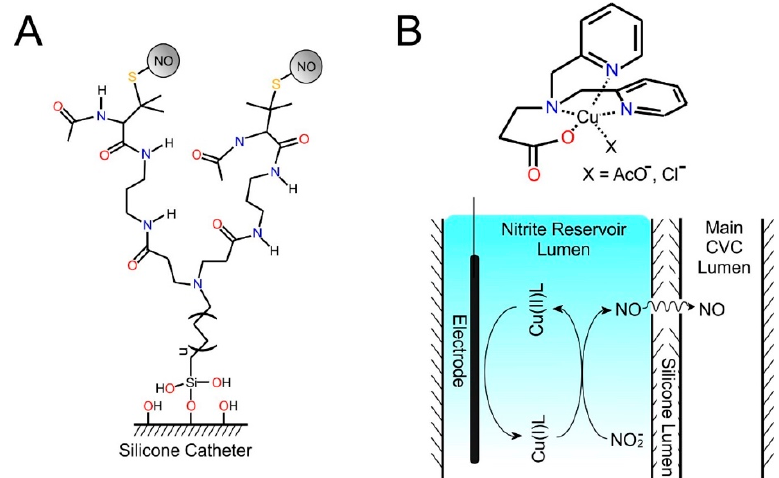
Figure 6. ( A ) Hyperbranched methacrylate-penicillamine based nitric oxide (NO) donors. ( B ) Dual lumen electrocatalytic release of nitric oxide using copper complexes.